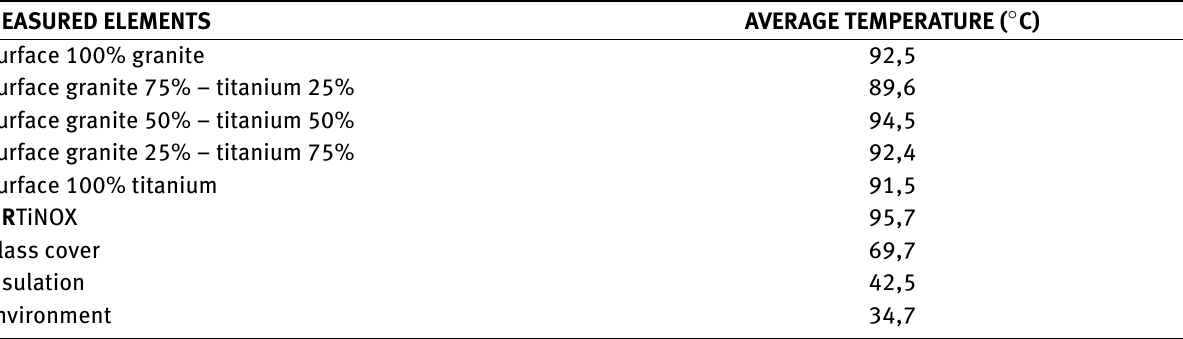
Table 2: Average temperatures for steady state operation for selective surfaces, for the environment, for glass and for experimental bench’s